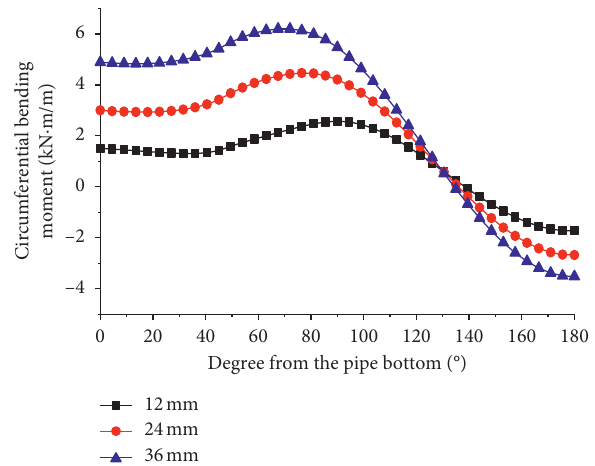
Figure 19: Circumferential bending moments with different pipe